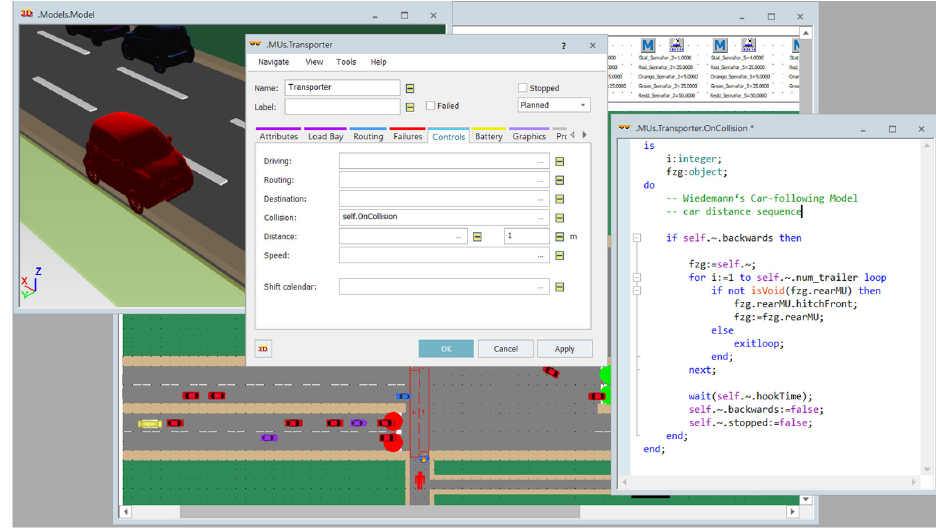
Figure 13. Part of a sequence to define driving modes.